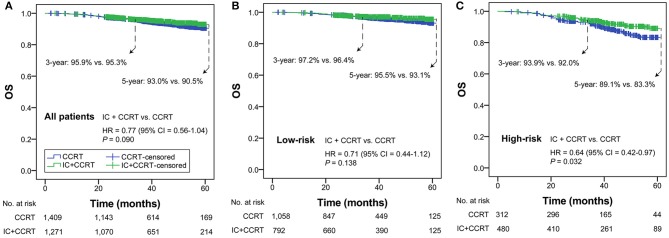
Kaplan-Meier OS curves of IC+CCRT vs. CCRT in the overall T3N0, T3N1, and T4N0 NPC (A), low- (B) and high-risk groups (C). HR, hazard ratio; CI, confidence interval; OS, overall survival; IC, induction chemotherapy; CCRT, concurrent chemoradiotherapy.